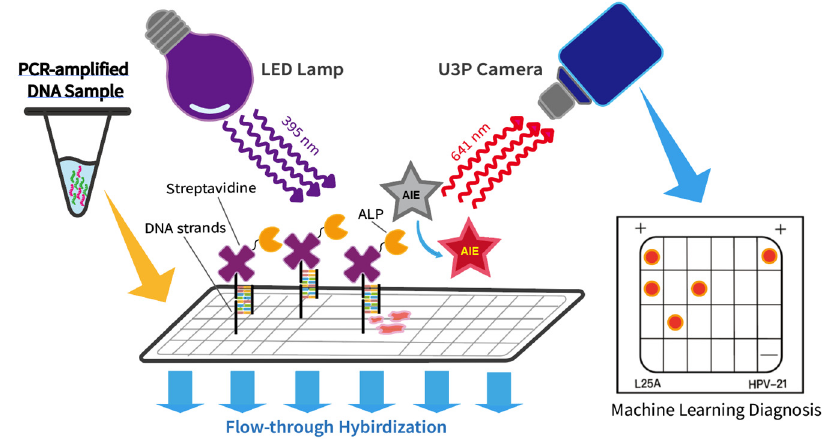
Figure 2. Schematic diagram of the HPV genotype detection platform based on aggregation-induced emission (AIE) and flow-through hybridization technologies.